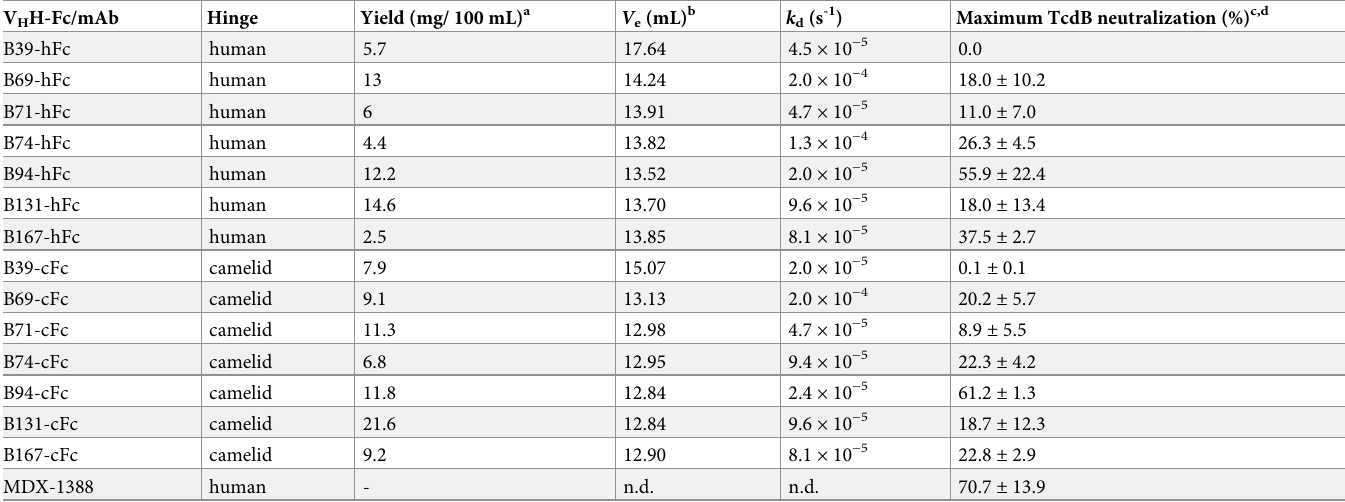
Table 3. Biophysical properties of anti-TcdB V H H-Fc